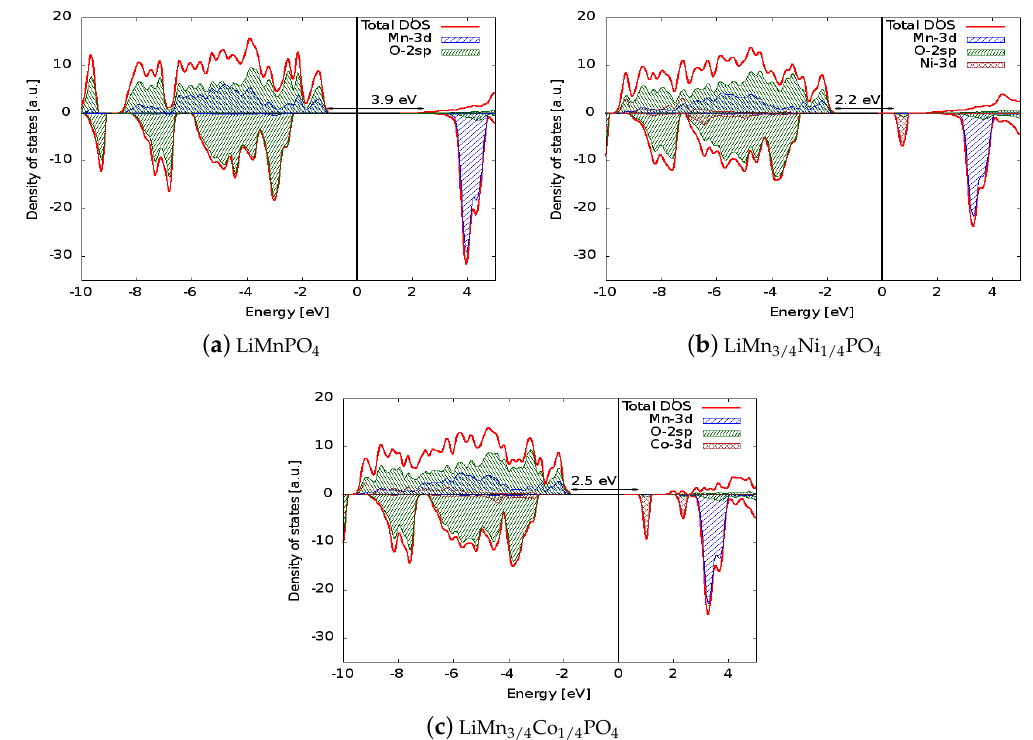
Figure 2. Comparison between the densities of states (DOSs) of ( a ) LiMnPO 4 , ( b ) LiMn 3/4 Ni 1/4 PO 4 , and ( c ) LiMn 3/4 Co 1/4 PO 4 . The Fermi energy was set to zero to allow direct comparison of the electronic structures. The positive (negative) axis is the majority (minority) spin direction. All materials are wide band gap semiconductors. Projected densities of states on transition metal atoms and oxygen are also